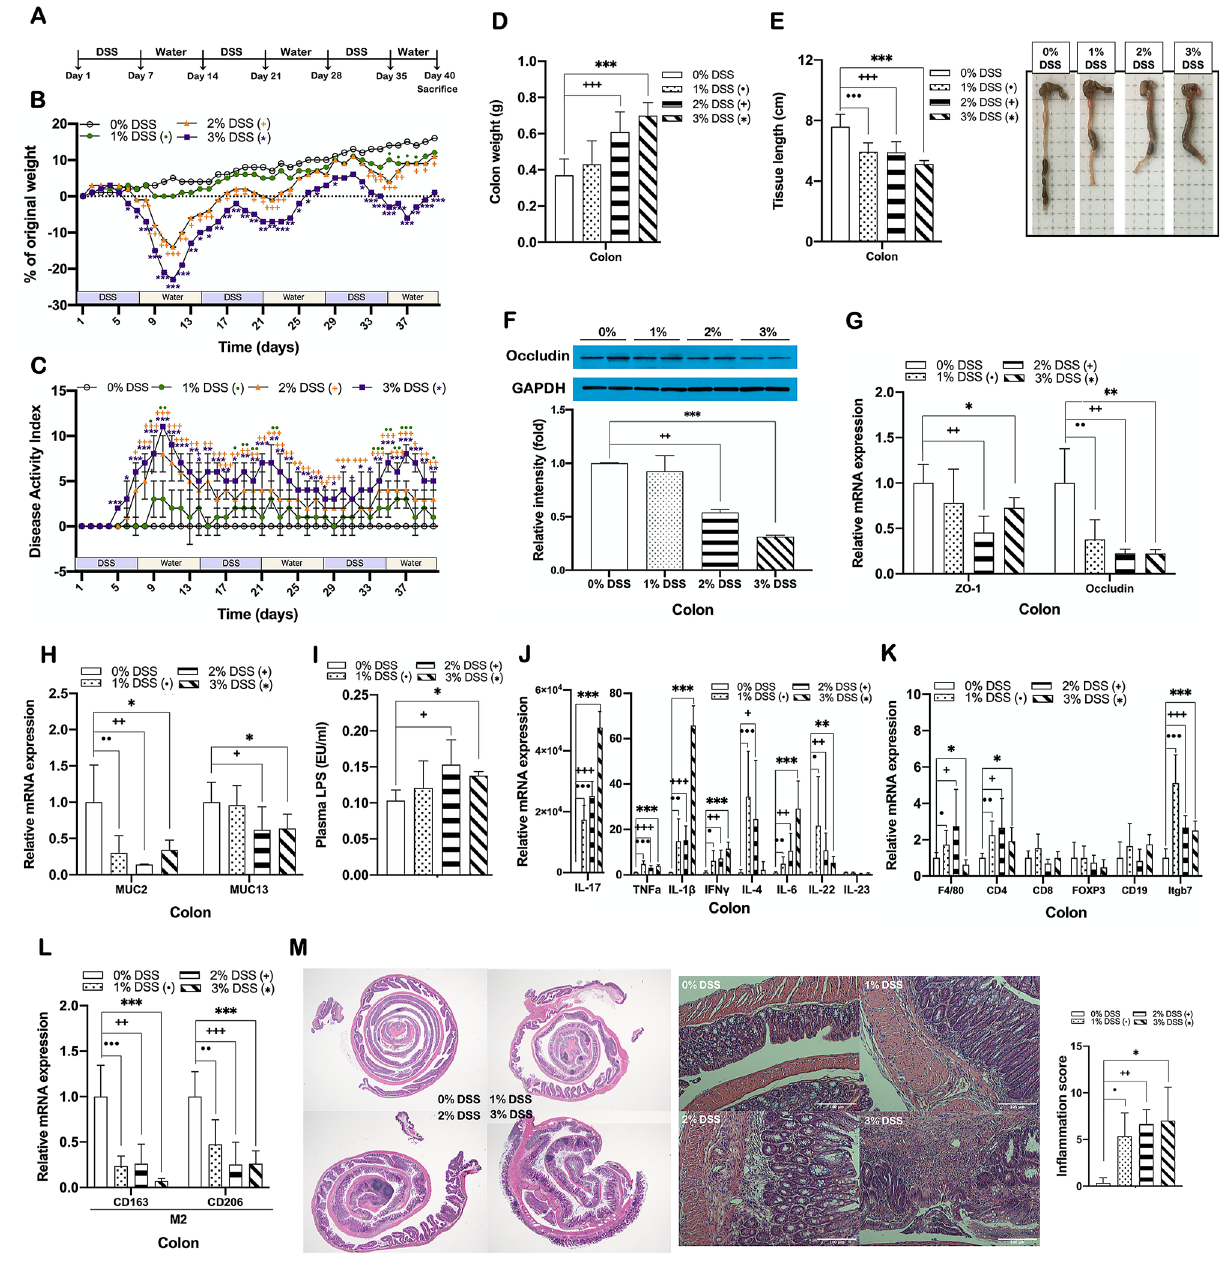
Figure 1. DSS-induced colitis mice display tight junction disruption and chronic inflammation in the colon. ( A ) Experimental scheme illustrating the cycles of DSS and water treatment. Changes in ( B ) body weight and ( C ) disease activity index (DAI) during 3 cycles of DSS treatment. ( D ) Colon weight and ( E ) colon length and representative photographs for colon tissue of DSS-treated and non-treated mice. Protein expression of ( F ) occludin, and mRNA expression of ( G ) tight junction proteins, ( H ) mucins, ( J ) inflammatory cytokines, ( K ) immune cell markers, and ( L ) M2 macrophage markers in the colon of DSS-treated and non-treated mice. Gene expression levels are normalized to GAPDH expression. ( I ) Plasma LPS level in DSS-treated and non-treated mice. ( M ) Representative images of H&E staining of Swiss roll section of colon segment (left; at ×12.5 magnification) and colon tissue (center; ×200; scale bar, 100 μm), and a graph representing inflammation score (right). Data present mean ± SD for 5–8 mice in each group. Statistical significance was determined using two-way ANOVA with ( B , C ) with Dunnett’s comparison test. •,+, * p < 0.0332, ••,++, ** p < 0.0021, •••,+++, *** p < 0.0002. Student’s two-tailed t-test was used for the analysis of differences between experimental groups ( D – M ). •,+, * p < 0.05, ••,++, ** p < 0.01, •••,+++, *** p < 0.001. 0% DSS, non-DSS-treated group; 1, 2, 3% DSS, 1, 2, and 3% (w/v) DSS-treated groups,